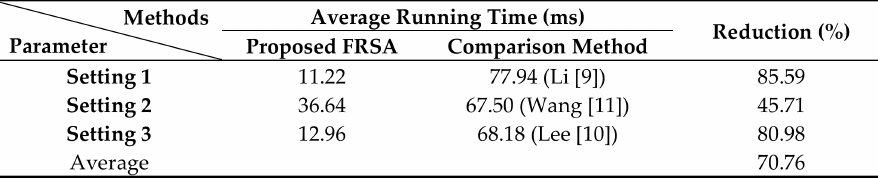
Figure 7. Comparison of cost with existing methods in different parameters. Figure 7 . Comparison of cost with existing methods in different parameters. Table 6. Comparison of average running time with related studies. Table 6. Comparison of average running time with related studies.